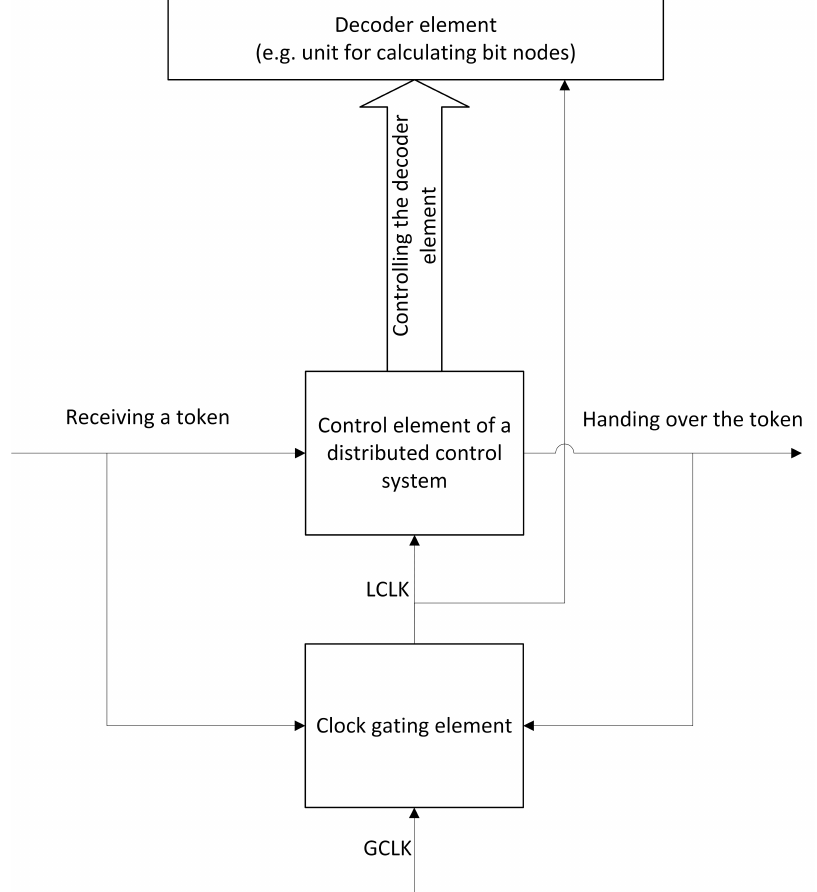
Figure 5. The block diagram of clock gating and activation of a distributed control element using a token in an architecture based on a Token Ring. Table 1. Analysis of the operation time of individual elements and the number of active Adaptive Logic Module (ALM) blocks of the QC-LDPC decoder based on the Token Ring architecture with the